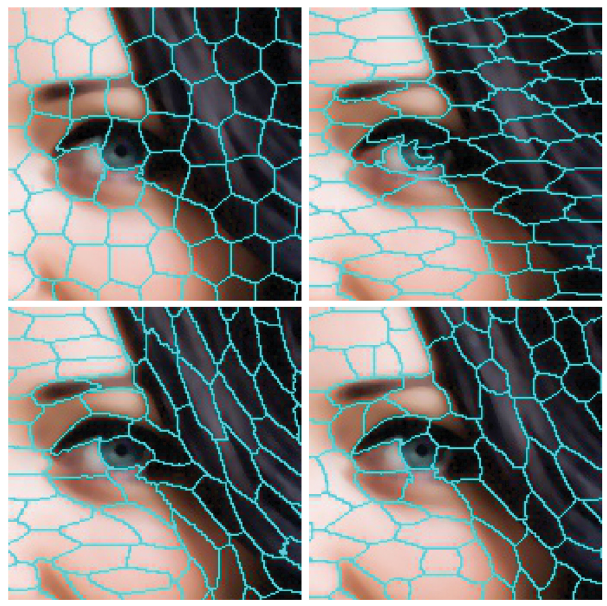
Fig. 4 Top left: original SLIC. Top right: scaling v y in Eq. (1) by α = 3. Bottom left: scaling (cid:3)v · (cid:3)b 1 in Eq. (3) by α = 3. Bottom right: using random scaling in Eq. (3).